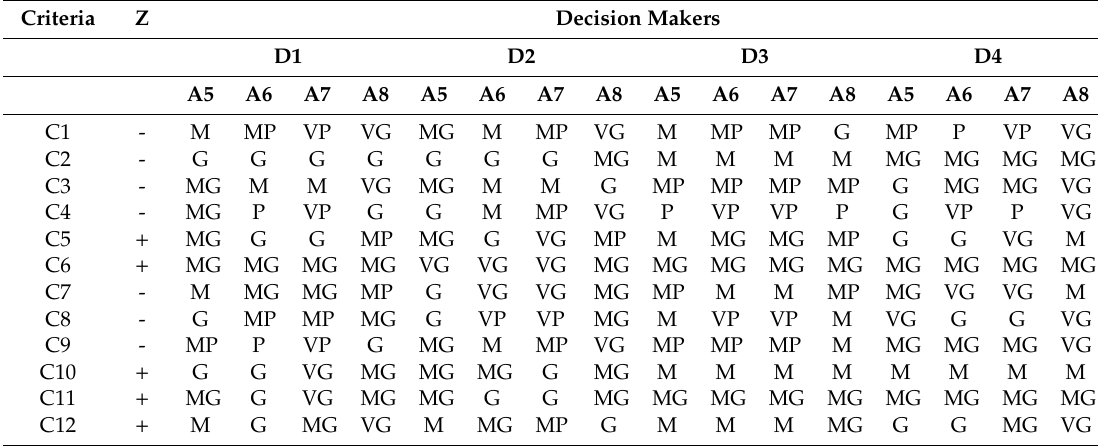
Table A3. Linguistic matrix of alternatives